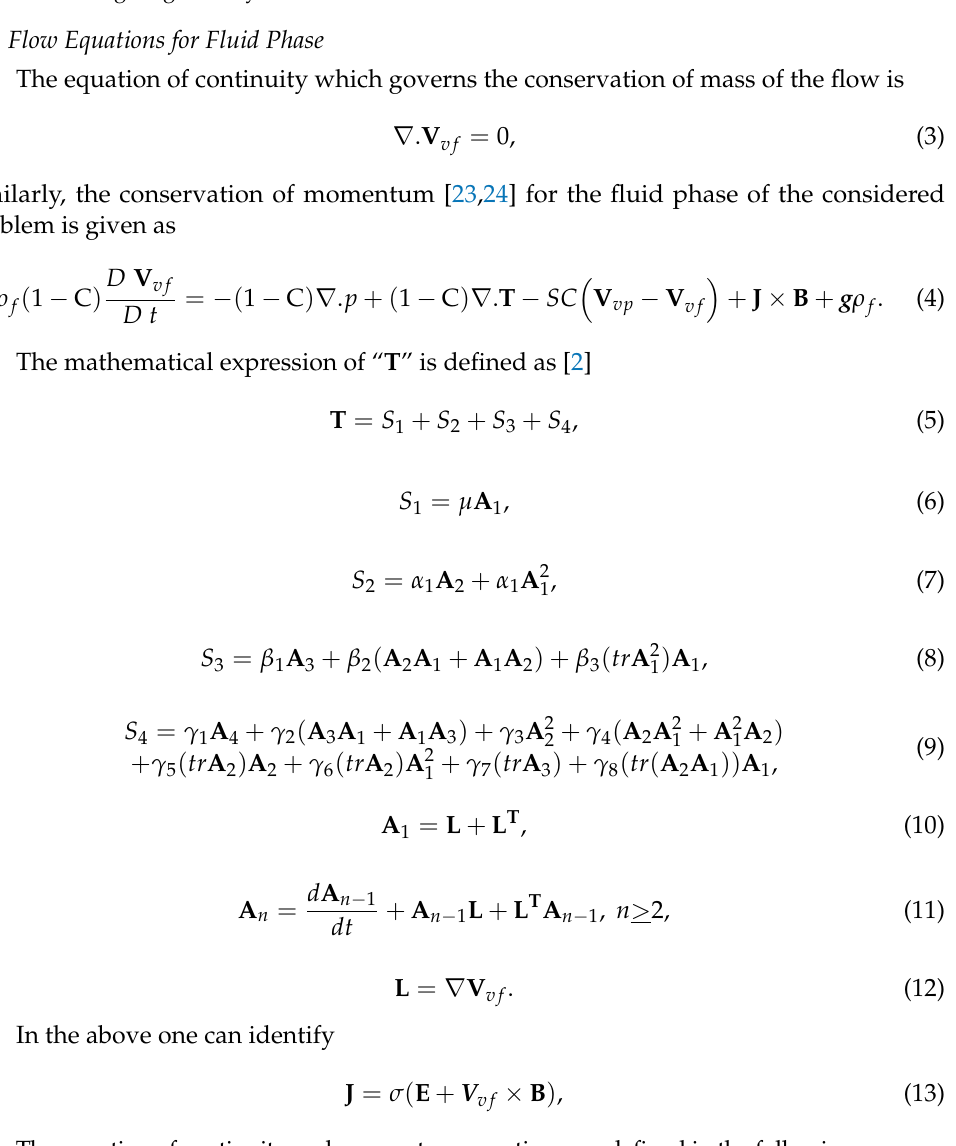
Figure 2. Divergent geometry.